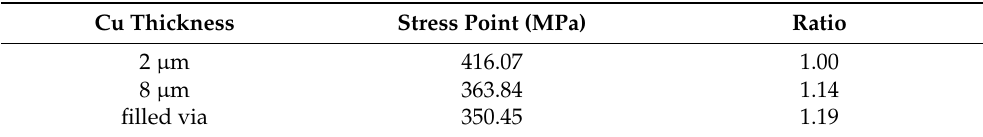
Figure 7. Stress distribution of the thickness of the Cu plating at 8 µ m during the cooling-down stage of the curing process. Table 2. Statistics of the stress value during the different thicknesses of Cu